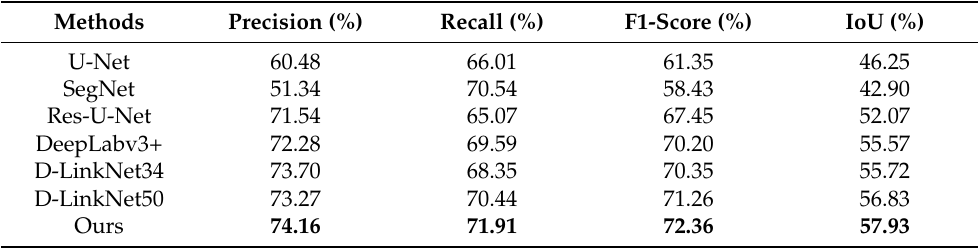
Table 4. The performance comparison of related methods on the Huawei test dataset.